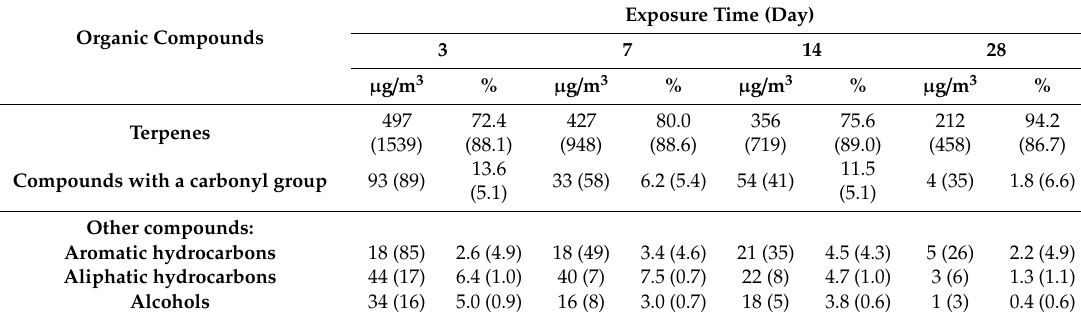
Table 5. Concentration of volatile organic compounds emitted from heartwood and sapwood part of Norway spruce wood ( Picea abies (L.) Karst.) after 3, 7, 14, 21 and 28 days of exposure of samples (values in brackets represent